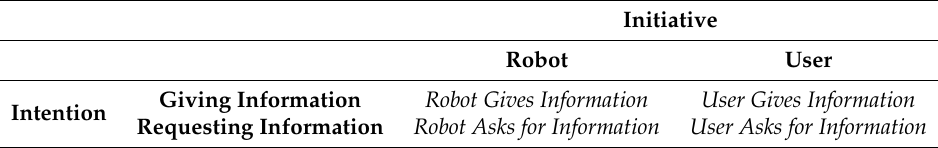
Table 2. Basic Communicative Acts (CAs) that have been currently